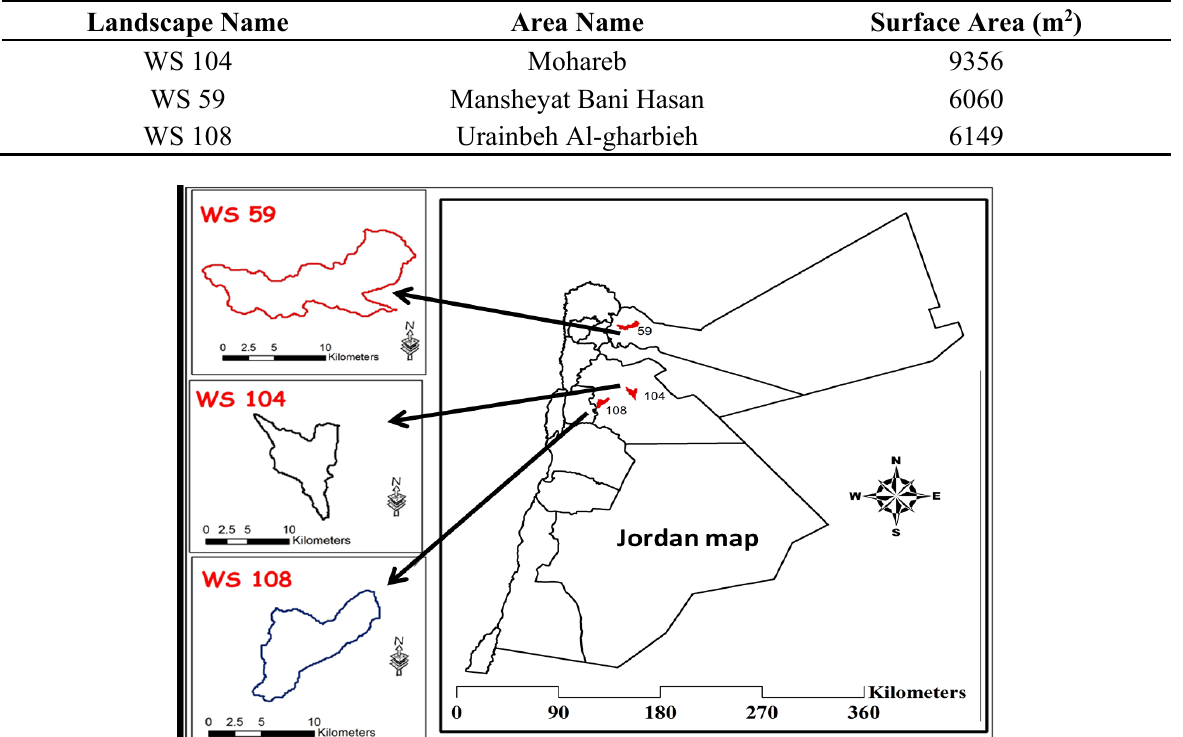
Figure 1. Landscapes